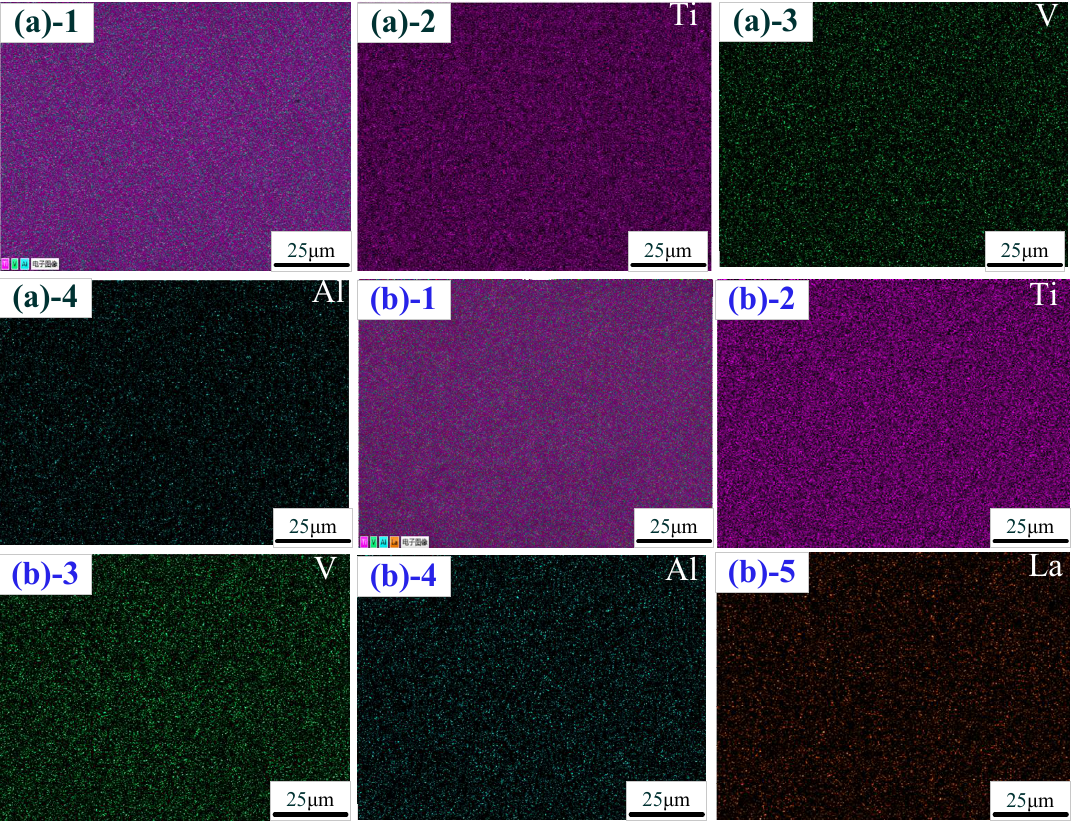
Figure 4. Distribution of the elements: ( a ) without La 2 O 3 ; ( b ) with La 2 O 3 . (Note: (a)-1–(a)-4 show the distribution of the elements with Ti-Al-V, Ti, Al and V; (b)-1–(b)-5 show the distribution of the elements with Ti-Al-V, Ti, Al, V and La).